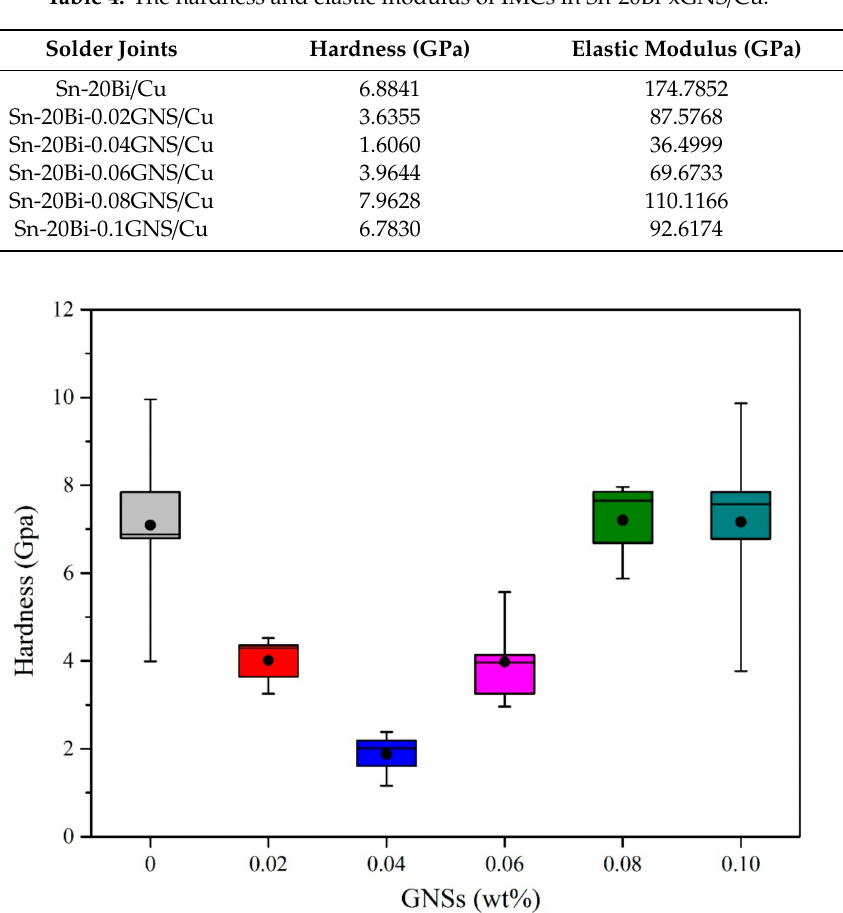
Table 4. The hardness and elastic modulus of IMCs in Sn-20Bi-xGNS / Cu.